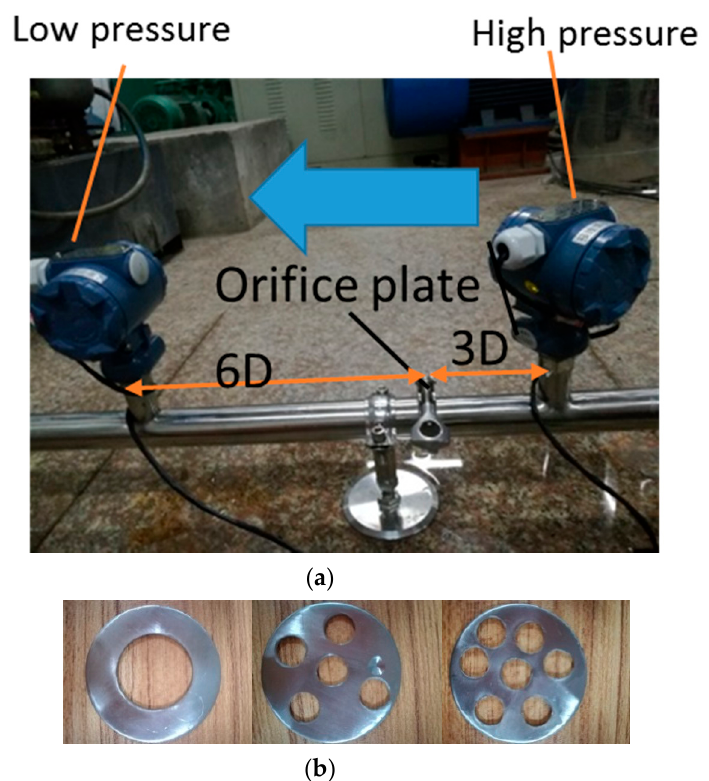
Figure 4. Illustration of the local resistance flowmeter; ( a ) the schematic diagram, ( b ) three sizes for the orifice plate.